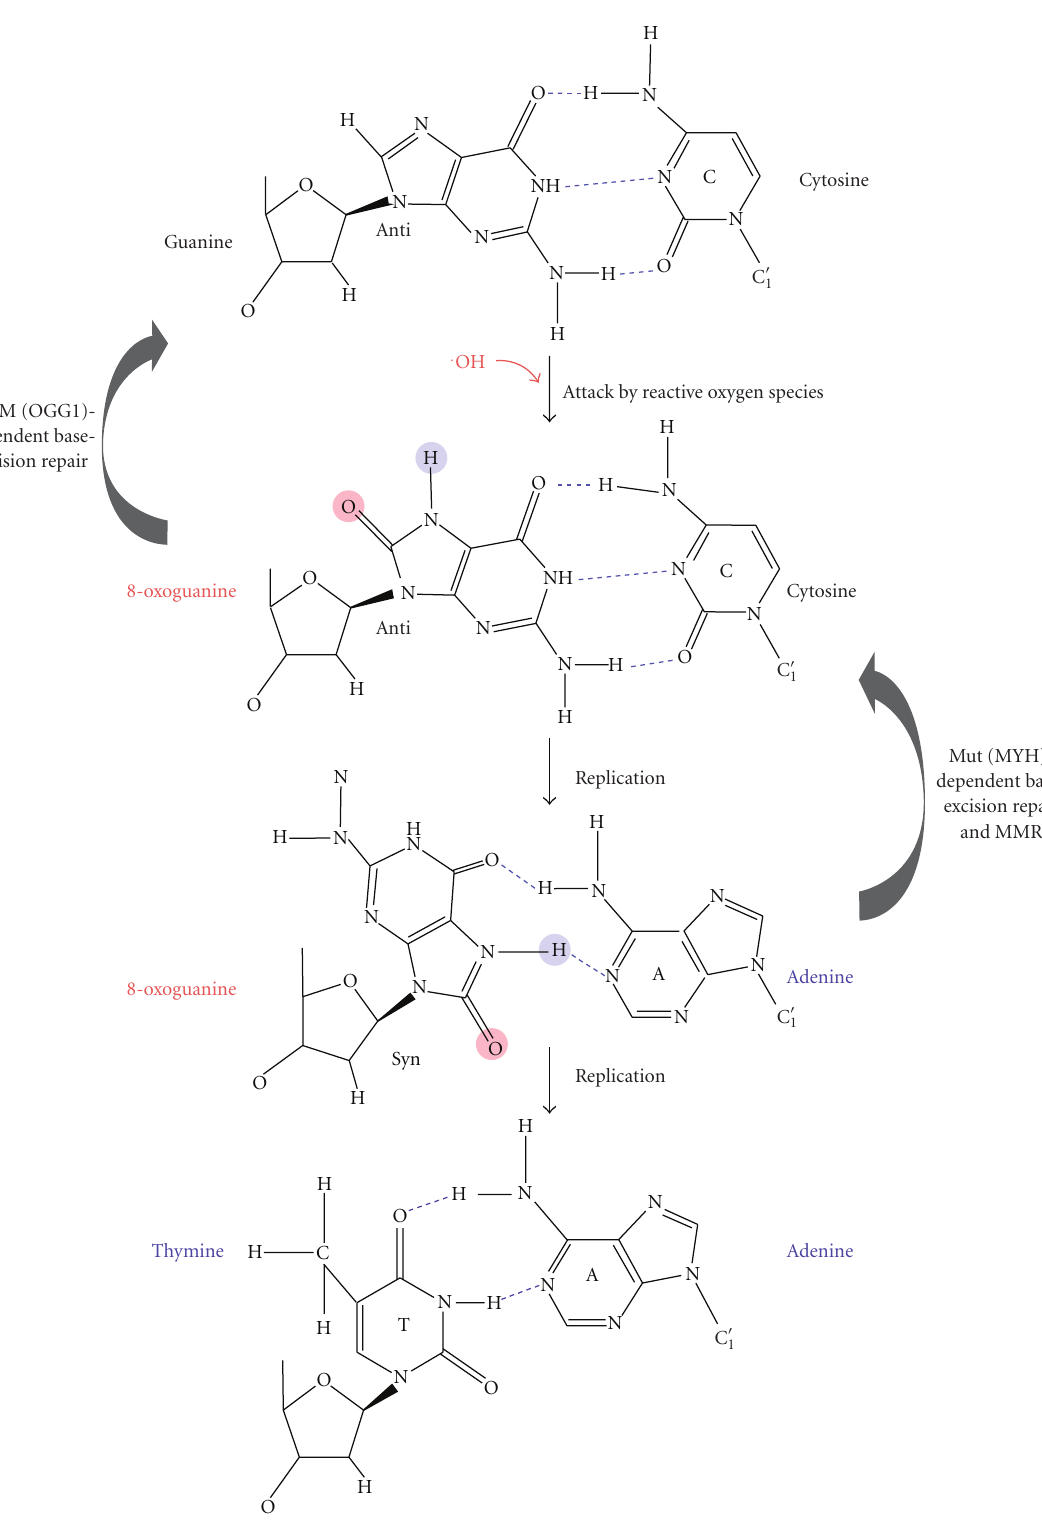
Figure 12: Prevention of 8OG-induced G:C-T:A transversion mutations. The 8OG base is one of the major forms of oxidative DNA damage and can be generated by reactive oxygen species. Since 8OG can pair not only with C but also with A, it causes a G:C-T:A transversion through DNA replication. MutM (OGG1)- and MutY (MYH)-dependent base-excision repair pathways are known to remove the 8OG and A from 8OG:C and 8OG:A pairs, respectively. MMR is also responsible for the removal of A from